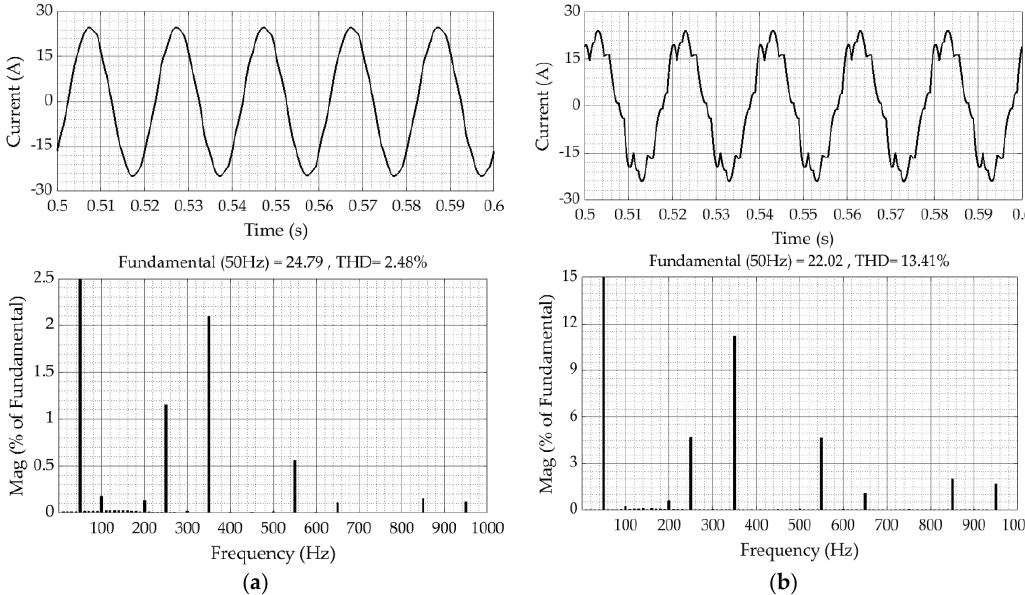
Figure 9. The output current obtained for Level 1 charging: ( a ) With LC filtering and ( b ) without LC filtering.